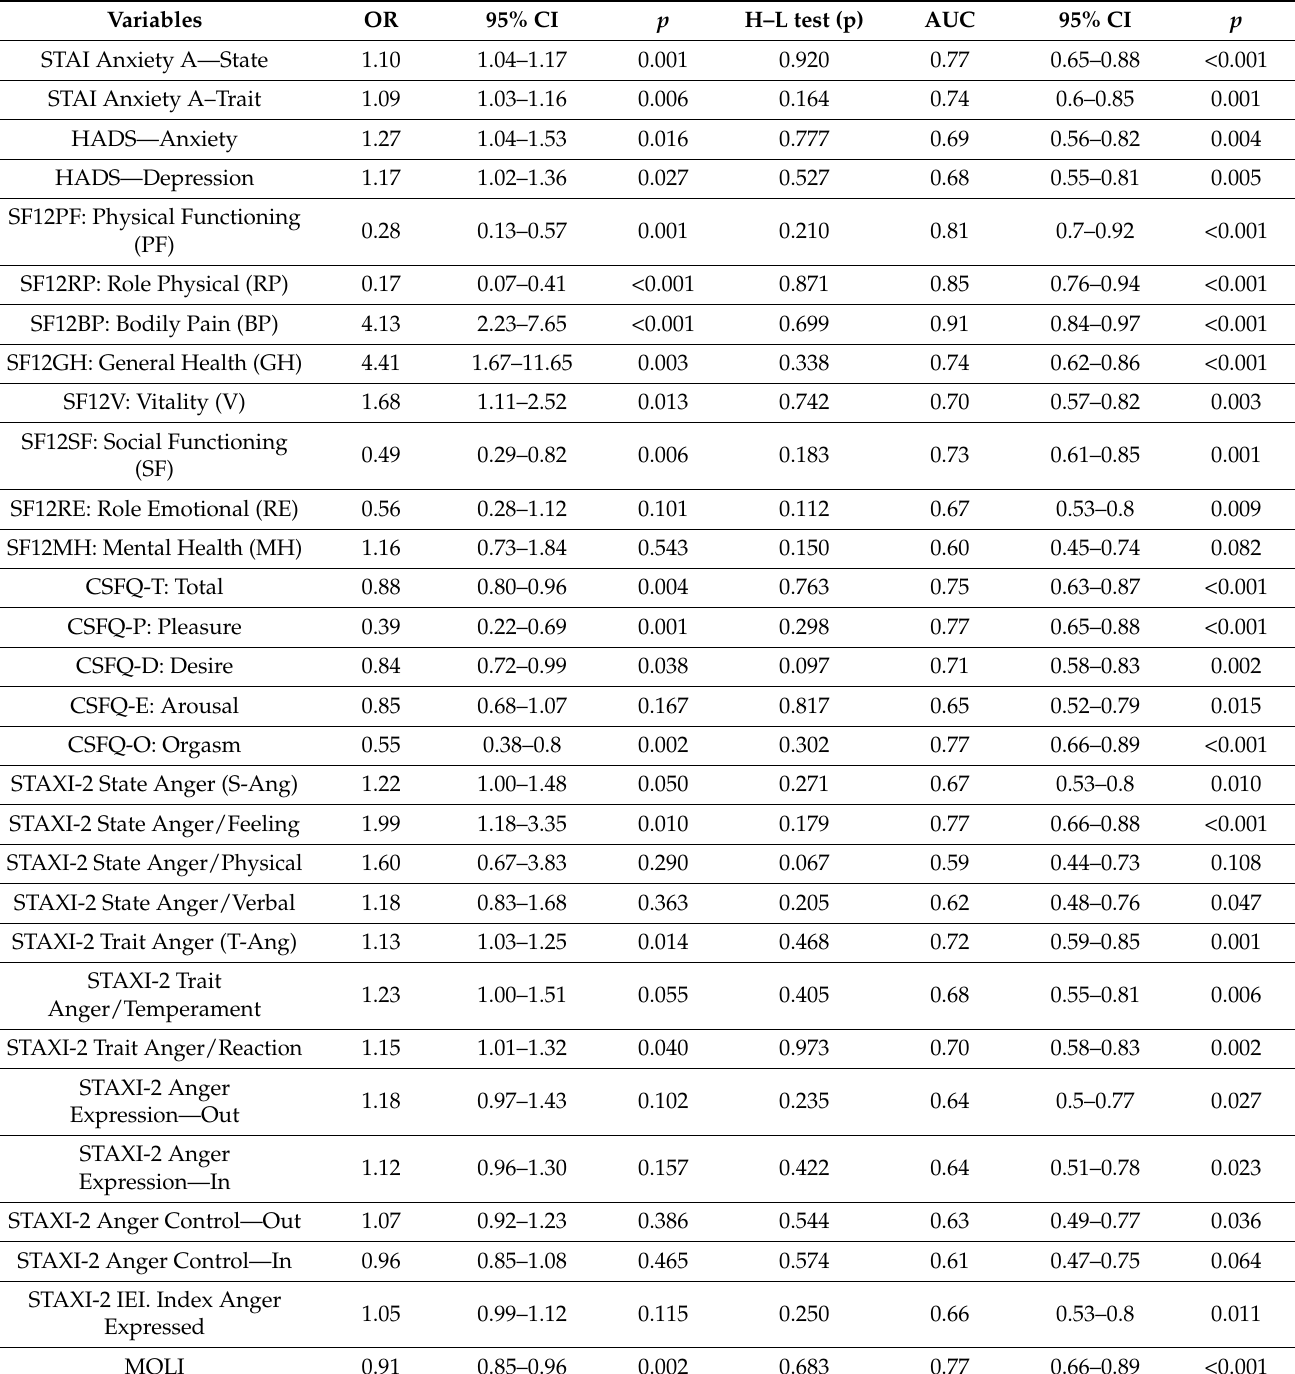
Table A2. Adjusted odds ratio (OR) to determine factors associated with the